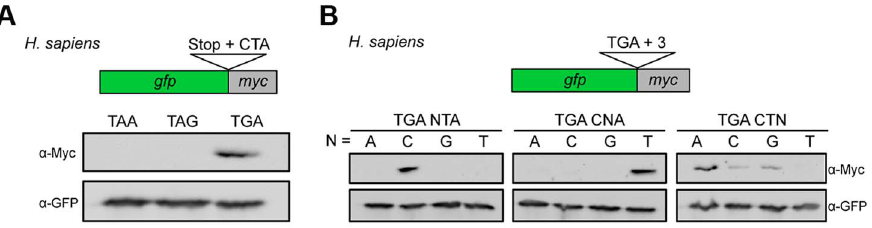
Figure 3. Characterization of sequence requirements for translational readthrough in human cells. (A) A reporter construct consisting of gfp and myc interrupted by a stop codon was expressed in HeLa cells. Stop codon readthrough was analyzed by detection of the myc-epitope by Western blot. The termination codon TGA was replaced by TAA or TAG and tested in combination with the downstream sequence CTA for ribosomal readthrough. (B) Nucleotides downstream of TGA were exchanged as indicated and tested as described in (A) for stop codon